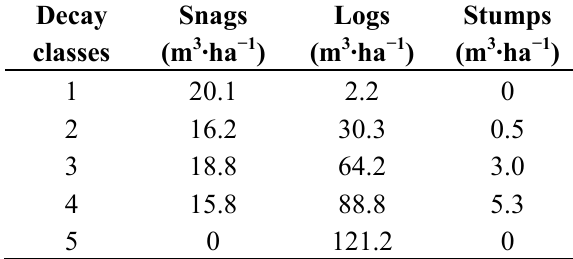
Table 3. Different decay classes of coarse woody debris in the core